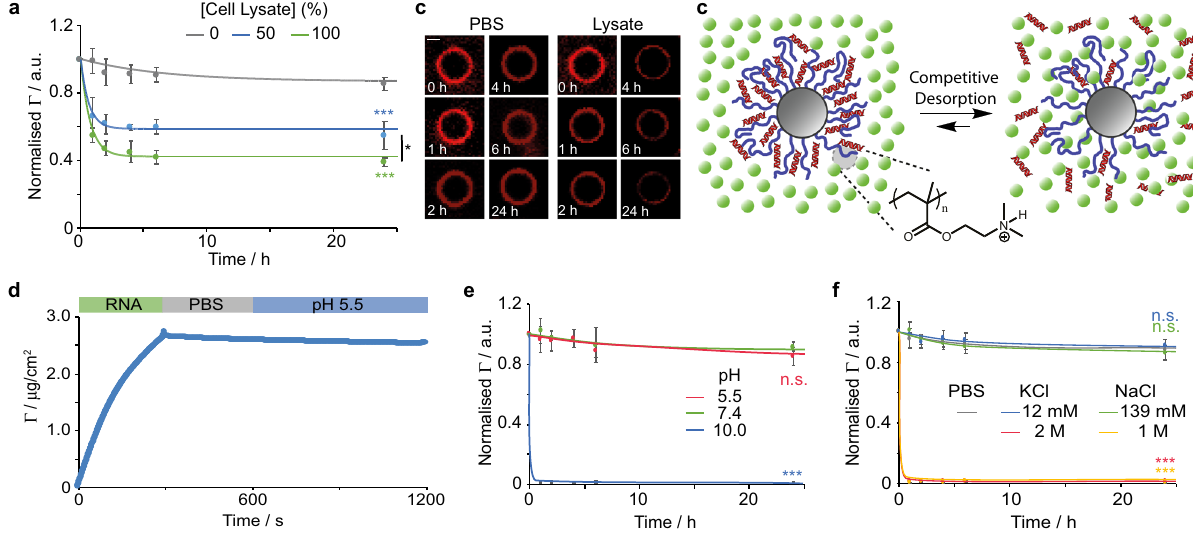
Fig. 2 Rapid desorption of RNA in cell lysates. a Release pro fi le of cy-5 tagged siRNA from PDMAEMA brush-functionalised microparticles in cell lysate- PBS mixtures (v/v %). b Corresponding fl uorescence microscopy images (scale bar, 1 μ m). c Schematic illustration of competitive desorption of siRNA from cationic PDMAEMA brushes. d Quanti fi cation of siRNA adsorption (10 μ g/mL; 50 μ L injected at 10 μ L/min fl ow rate) on PDMAEMA brushes, measured by SPR, followed by washing in PBS at neutral pH and pH 5.5. Release pro fi les of cy5 siRNA from PDMAEMA brush-functionalised microparticles at different pH (in PBS, e ) and electrolytes ( f ). a.u., arbitrary units. Data are presented as mean values. Error bars are standard errors from